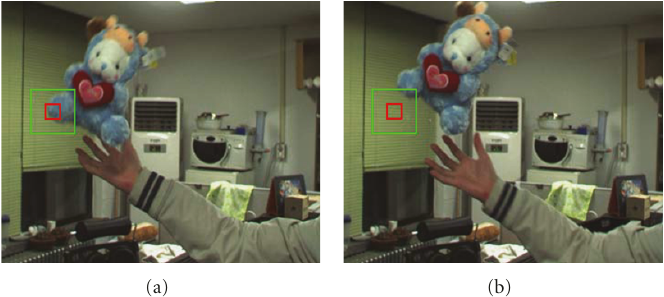
Figure 4: A red square depicts a block, whereas a green square depicts a macroblock. The pdf’s for the background and the object layers are estimated for each block separately, but the pdf’s for the nine blocks, which compose a macroblock, are averaged for the color modeling.